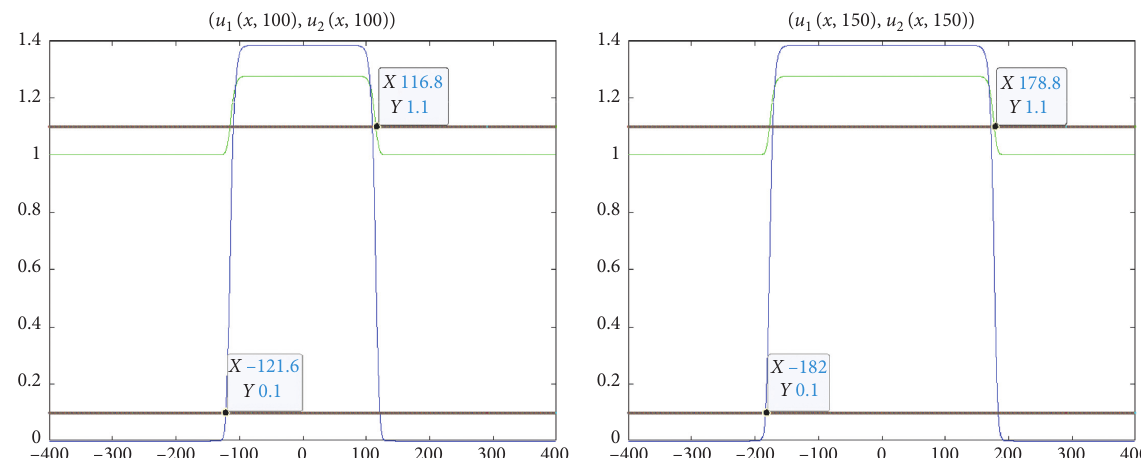
Figure 4: Spatial plots of u